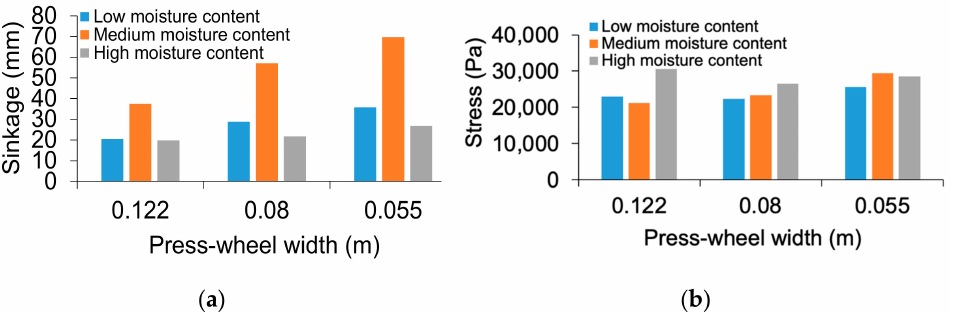
Figure 10. ( a ) Sinkage results for different press-wheel widths under different soil moisture levels; ( b ) soil stress versus press-wheel widths under different soil moisture